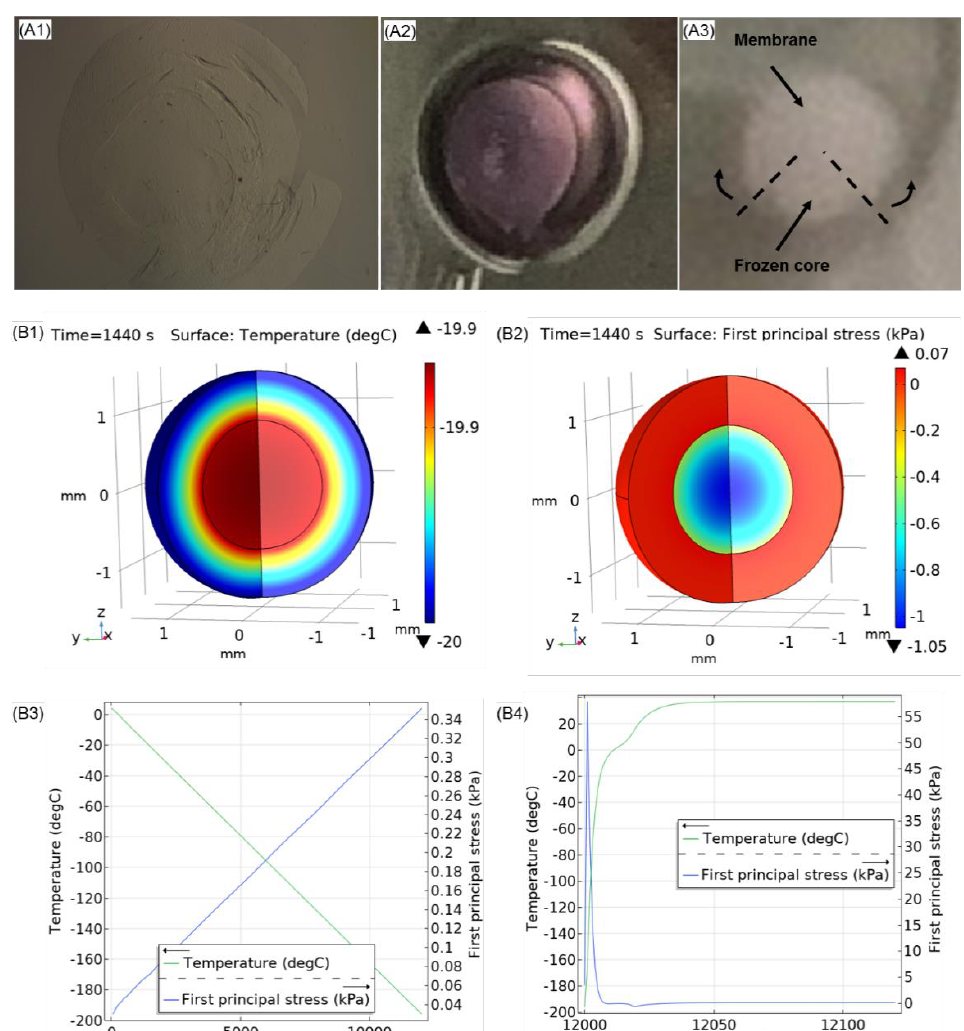
Figure 11. Representative images of cell-free core-shell capsules highlighting the shell damage ( A ) and modelling results for the temperature as well as the maximum principal stress distributions during freezing and thawing ( B ). ( A1 , A2 ) Show a bright-field picture and photo of a damaged core- shell capsule after thawing, respectively, whereas ( A3 ) is an enlarged view of a damaged core-shell capsule indicating potential places with increased thermal stresses (curved arrows). The dashed lines define release of a frozen core from a capsule. The core-shell capsules were frozen in a 12-well plate with the application of 10% DMSO and 30 min loading time. Cryopreservation was performed in an Asymptote VIA Freeze Research (Cambridge, United Kingdom) controlled-rate freezer with a cooling rate of 1 K/min down to −70 °C. Warming was conducted passively “in air” without the application of a pre-warmed water bath. ( B1 ) Temperature distribution and ( B2 ) spatial principal stress distribution at −20 °C during slow freezing of a model core-shell capsule in a cryovial; tem- perature and principal stress dependencies during cooling ( B3 ) and warming ( B4 ).